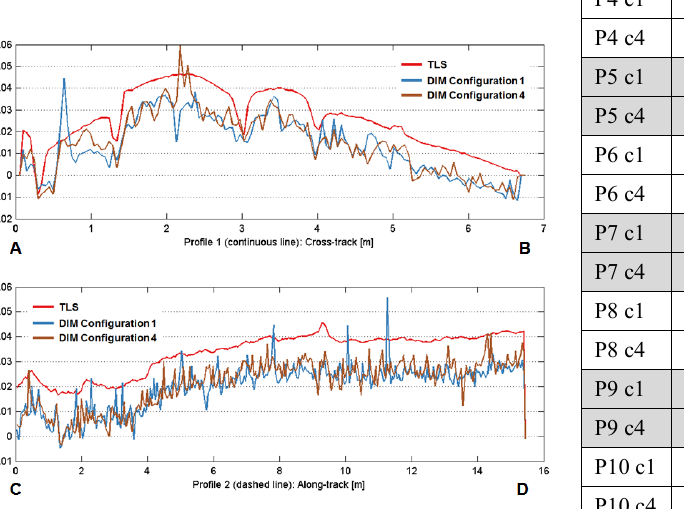
Figure 13. Deviations DIM-TLS of road patch 2